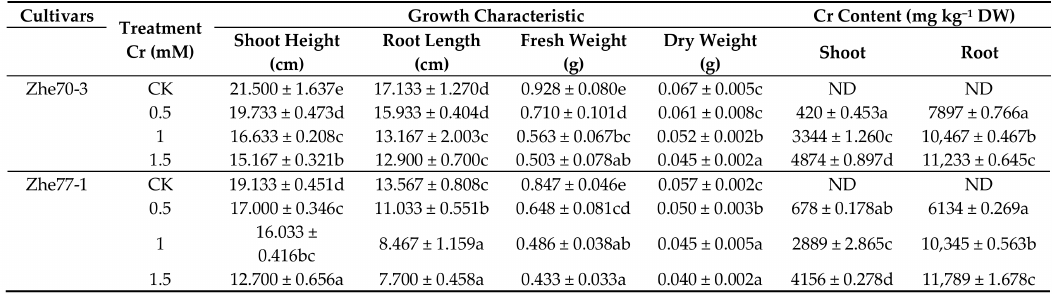
Table 2. Effects of Cr treatments on growth characteristics and Cr content in shoot and root of kenaf cultivars Zhe70-3 and Zhe77-1.